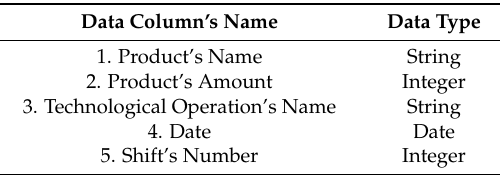
Table 4. Structure of the production plan data